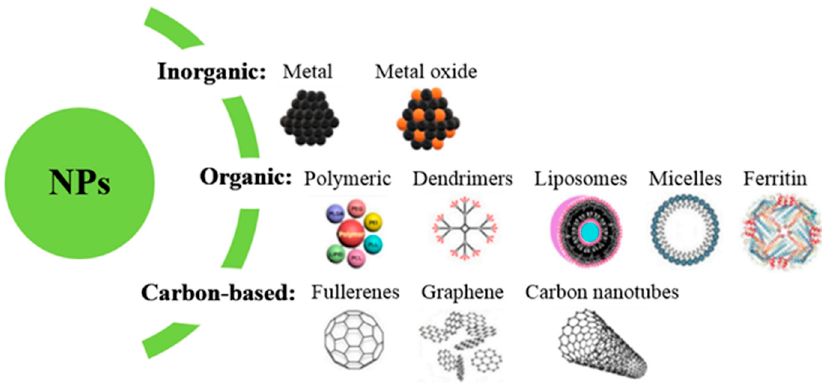
Figure 1. Chemical composition-based classifications of NPs [11].